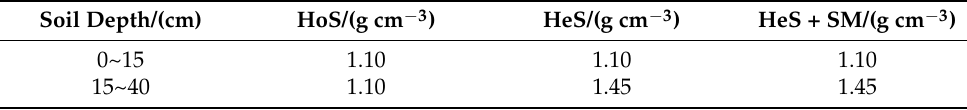
Table 2. Backfilling bulk density of soil